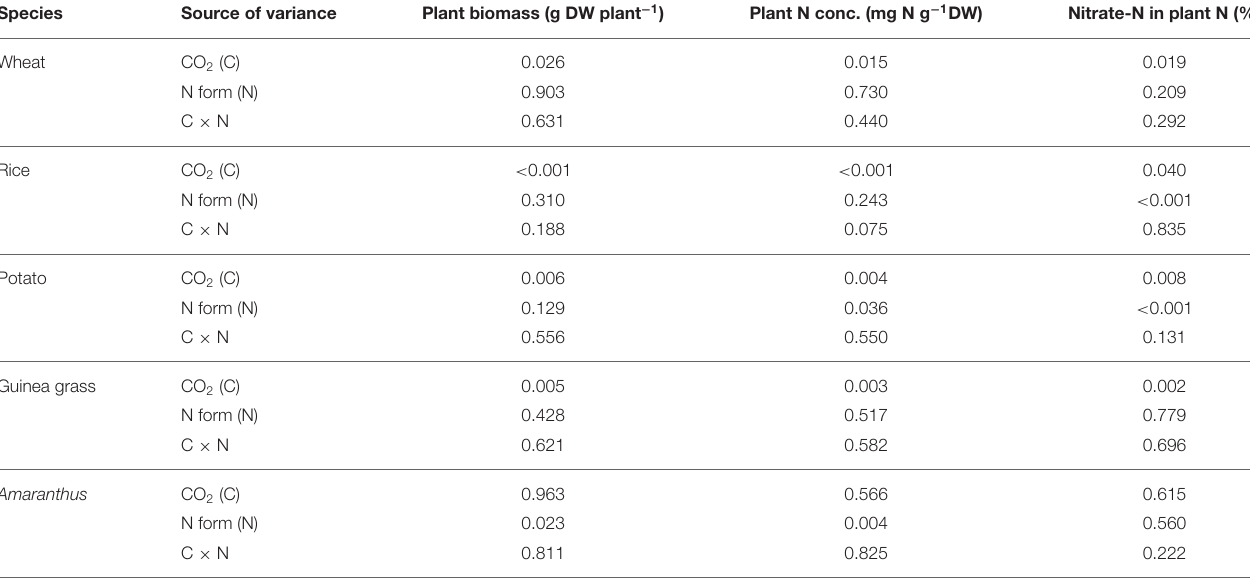
TABLE 2 | Probabilities by two-way analysis of variance (ANOVA) for plant biomass, plant N concentration, and the percentage of nitrate-N in plant total N in nitrate-fed or urea-fed plants in five species grown for 28 d in the chambers under ambient (aCO 2 ) or elevated (eCO 2 ) CO 2 treatments.